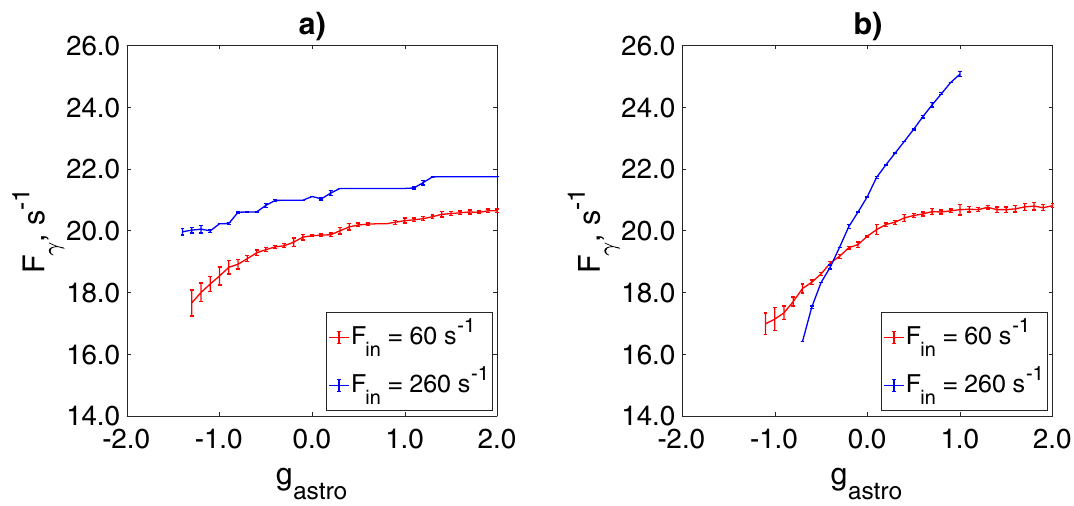
Figure 8. Dependencies of the network oscillations frequency on the astrocytic modulation strength, g astro for the astrocyte-mediated regulation of the inhibitory synaptic transmission ( a ) and of the excitatory synaptic transmission ( b ) for two different values of F in